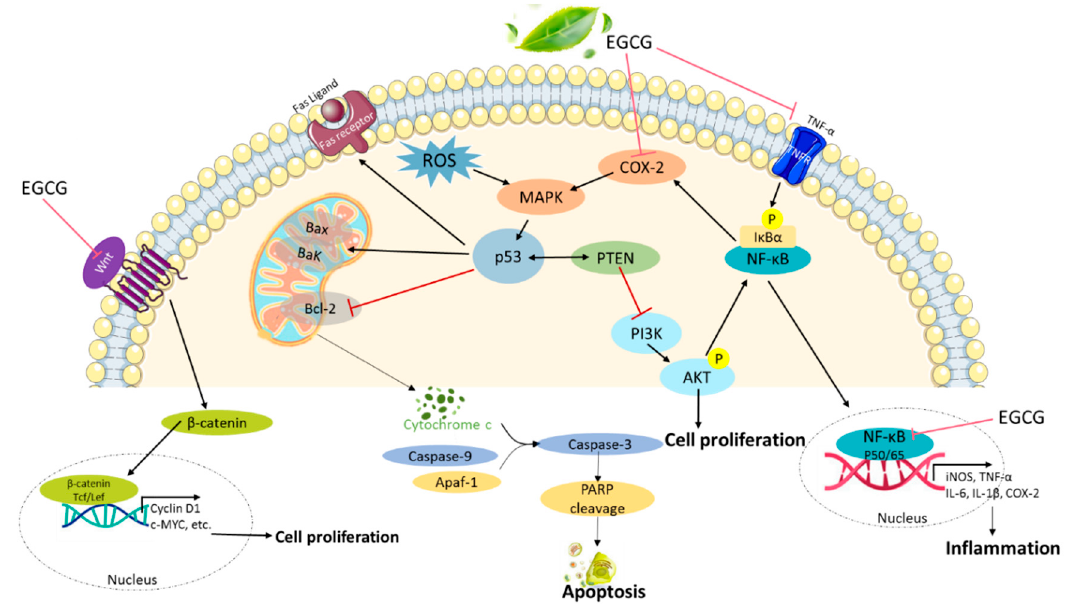
Figure 1. Molecular mechanisms of the ( − )-epigallocatechin gallate (EGCG) inhibition of inflammation and proliferation and induction of apoptosis. EGCG downregulated multiple signal pathways, such as the PI3K / AKT, NF- κ B, and Wnt signaling pathways, to inhibit cellular proliferation and inflammation and induce apoptosis. PI3K, phosphoinositide-3-kinase; AKT, protein kinase B; NF- κ B, nuclear factor- κ B; COX-2, cyclooxygenase-2; ROS, reactive oxygen species; and PTEN, phosphatase and tensin homolog.